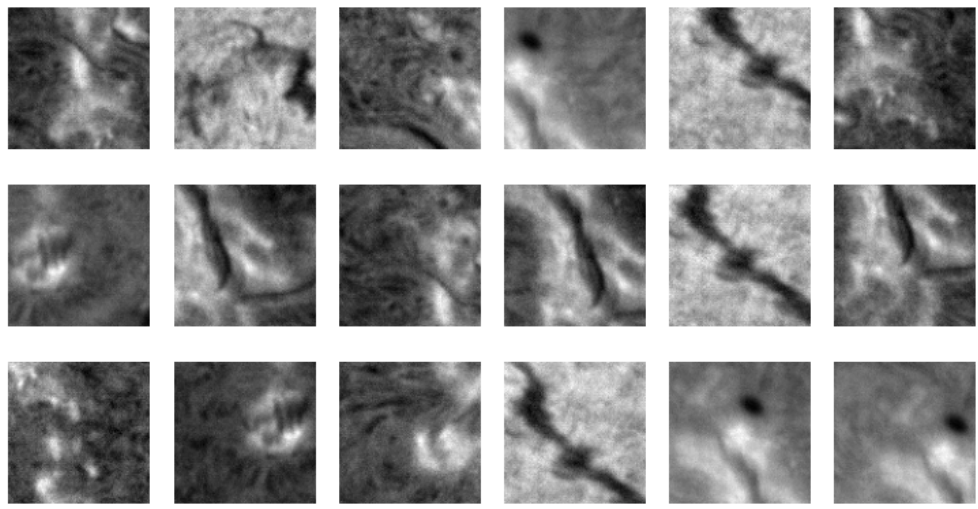
Figure 5. Patches selected in the first 15 runs of the adopted procedure performed on a chromospheric image presented on the left side of Figure 4.